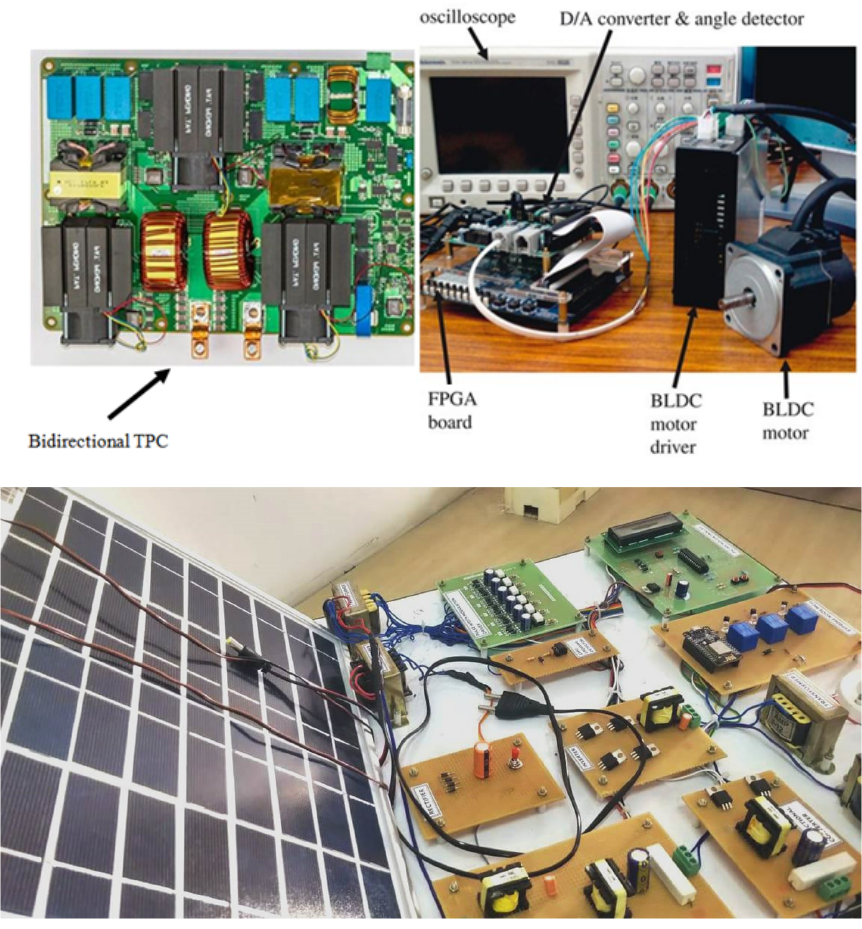
Figure 8. The Experimental Setup.